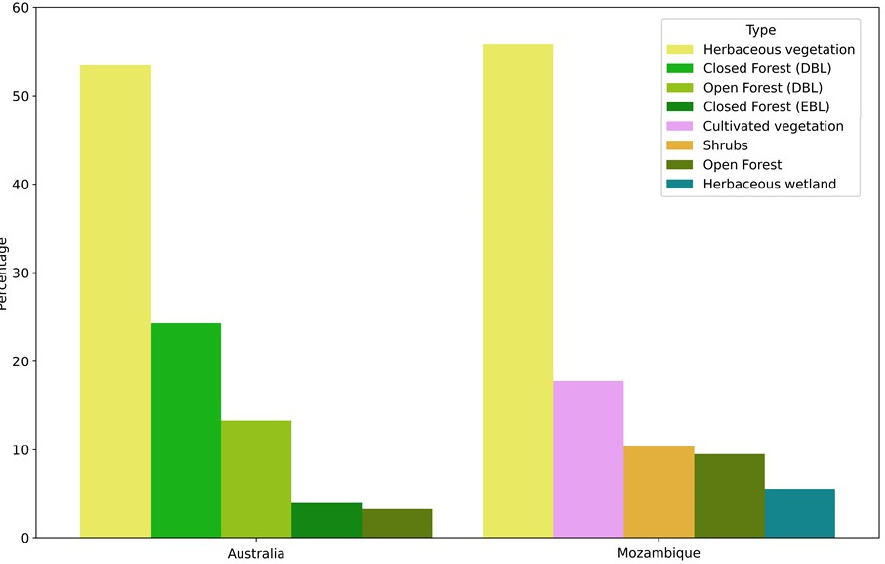
Figure 17. Percentage of area for each of the mainland cover types for Australia and Mozambique sites.